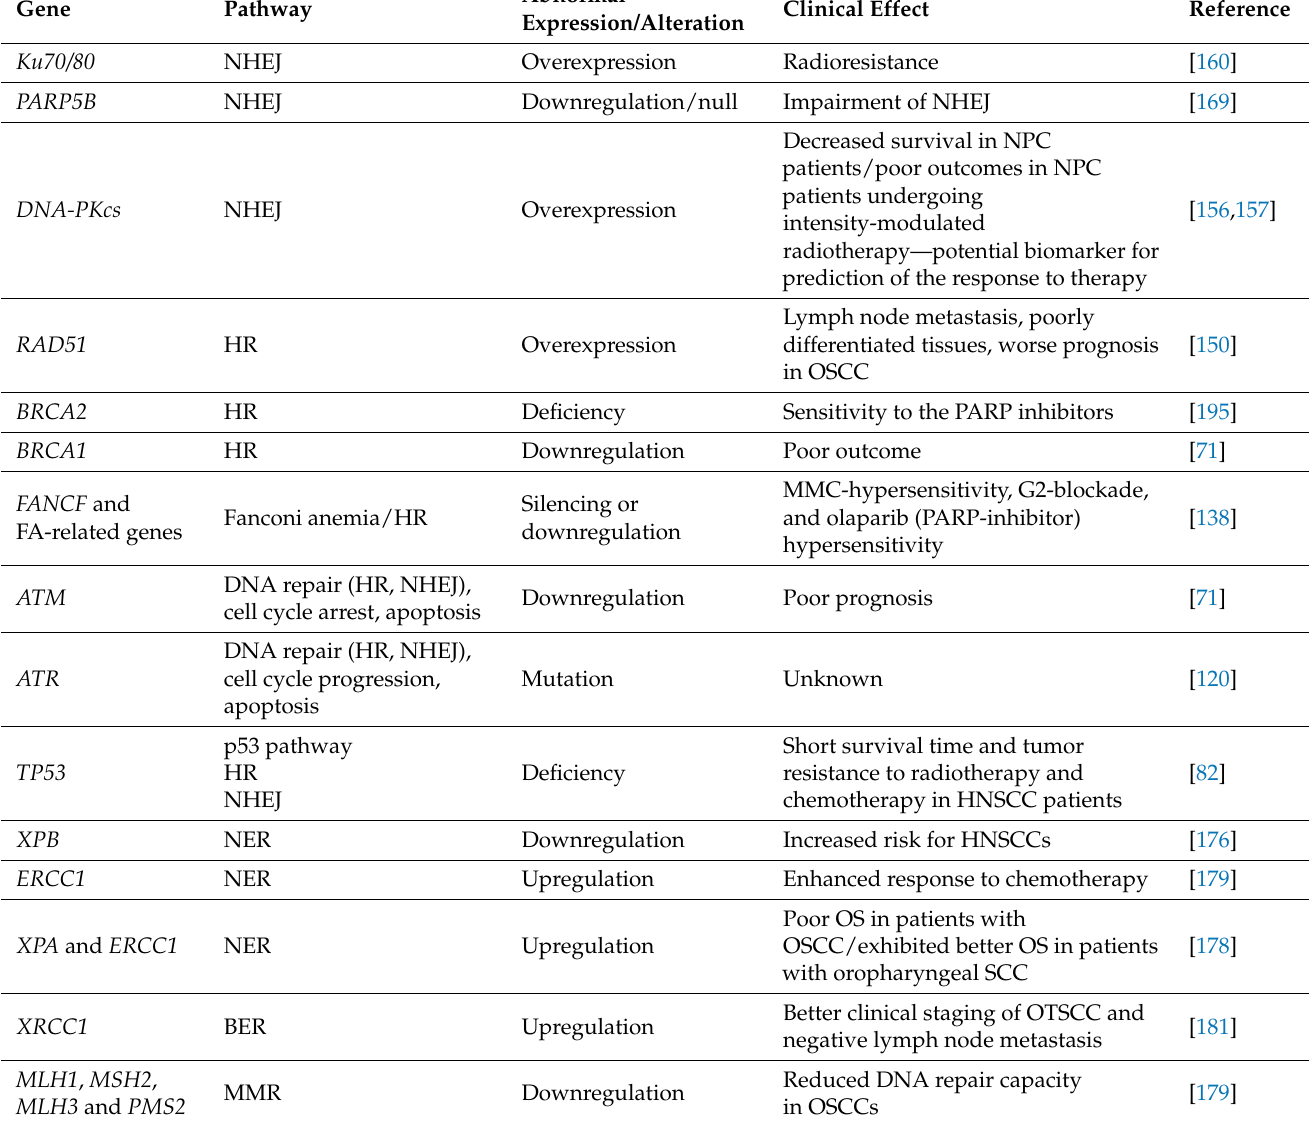
Table 1. List of genes that are deregulated in the DDR pathways in HNC and related clinical